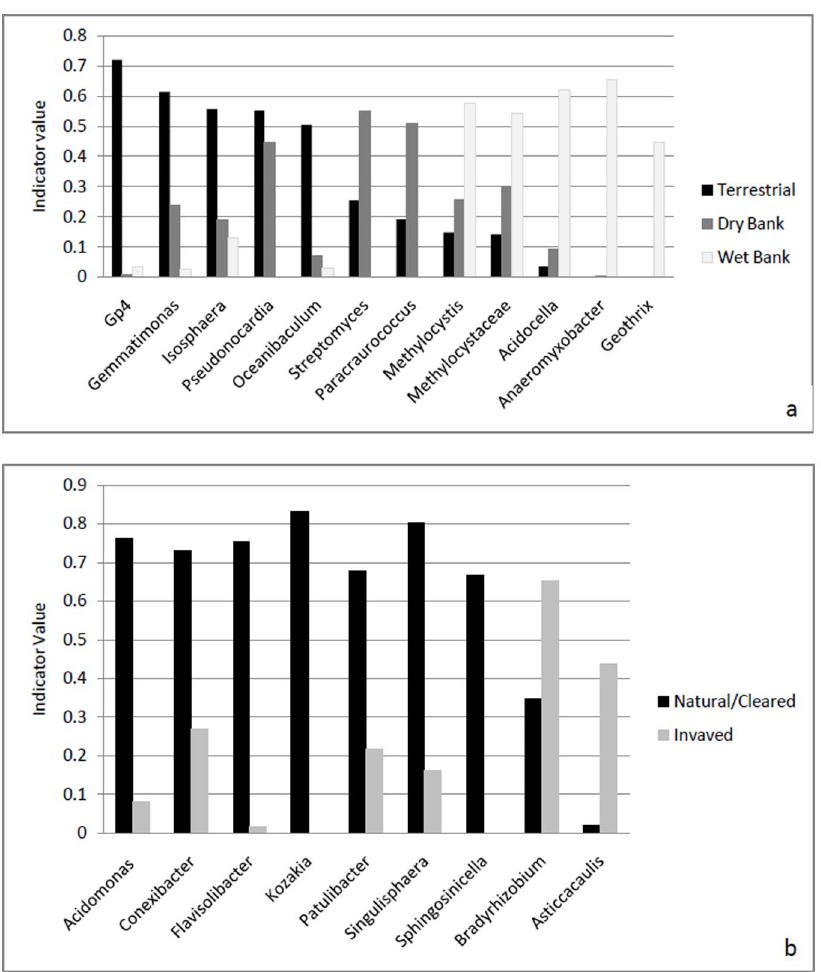
Figure 7. a: The indicator values of the indicator phyla in the community between lateral zones (p , 0.05). b: The indicator values and the relative abundance of the indicator phyla in the community when comparing invasive status (p , 0.05).